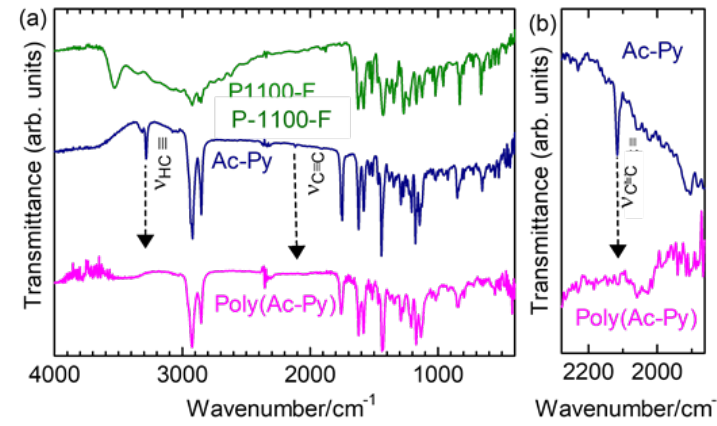
Figure 1. ( a ) Fourier-transform infrared (FT–IR) absorption spectra of P-1100-F (mesogen), Ac–Pyr